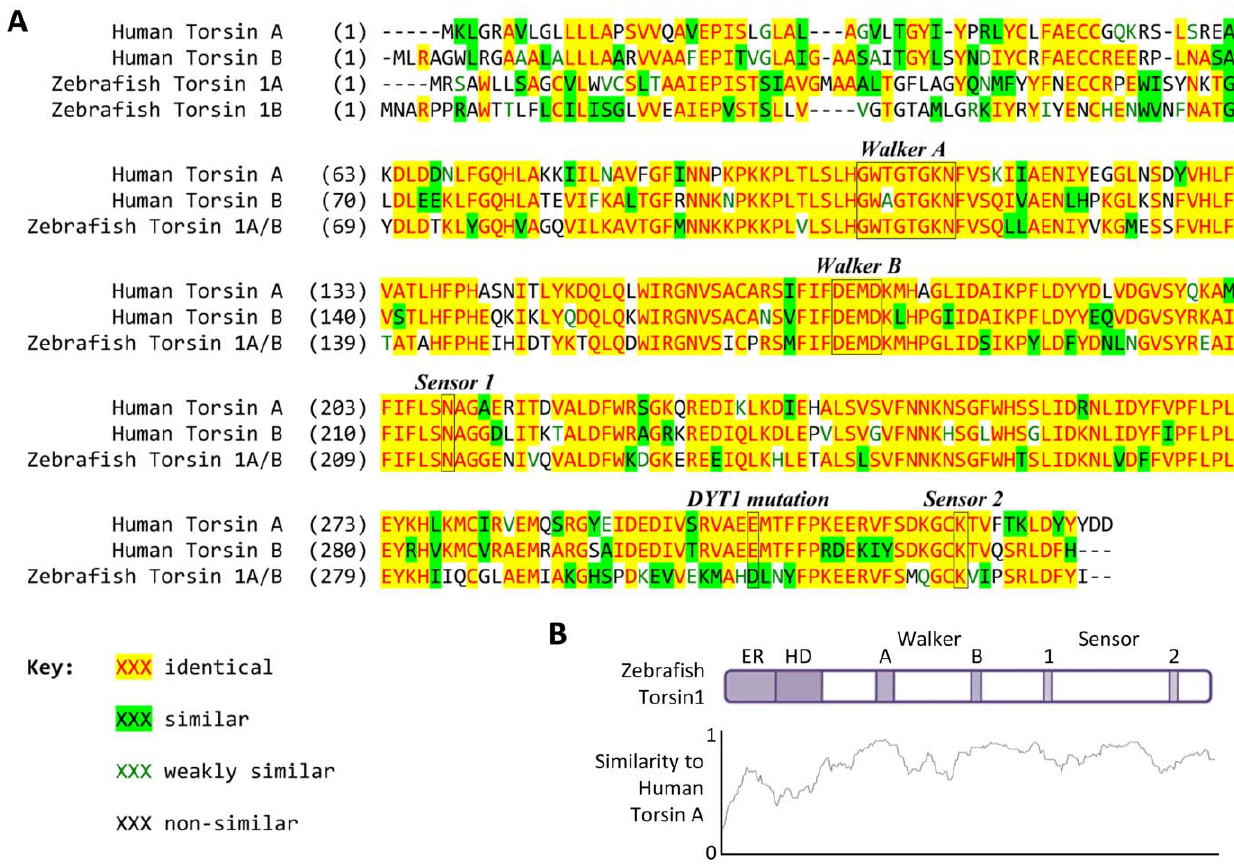
Figure 7. Zebrafish and human Torsin1 family proteins are highly homologous. A: The AlignX implementation of the ClustalW algorithm was used to align the amino acid sequences of zebrafish Torsin1a and 1b, and human TorsinA and TorsinB. The Walker A (ATP binding), Walker B (ATP hydrolysis), Sensor 1 and Sensor 2 domains are labeled. The position of the glutamic acid deletion associated with DYT1 dystonia is indicated. Identical and similar amino acids at each position of the alignment are colored as shown. B: Zebrafish Torsin1a is depicted schematically showing the functional domains discussed in the text. The graph below shows similarity between zebrafish Torsin1a and human TorsinA at each position of a sliding 15-amino acid window of comparison, corresponding to the schematic drawing of Torsin1 above (0=no homology, 1=identity). Key: ER, endoplasmic reticulum signal; HD, hydrophobic domain.